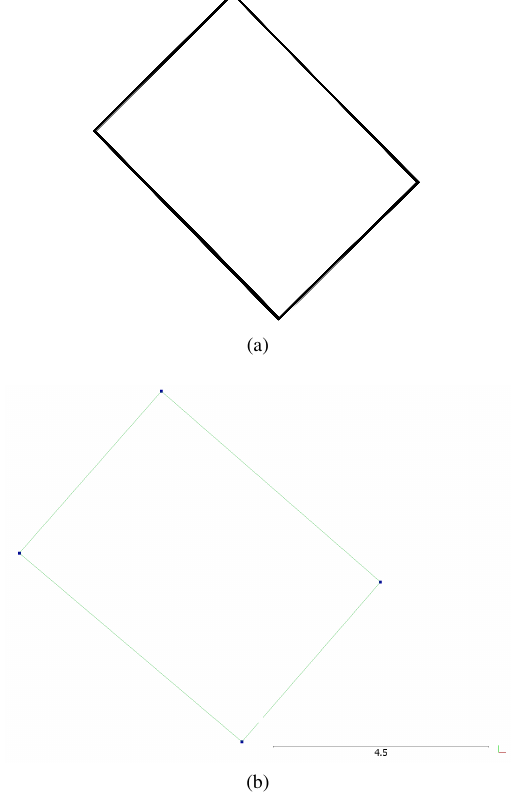
Figure 13: Final result for the convex room: (a) reference planimetry, (b) extracted planimetry.